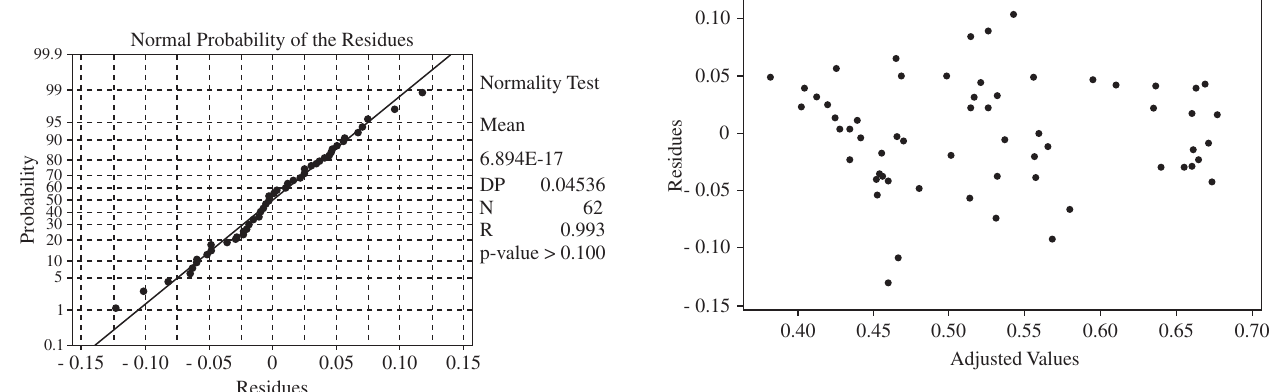
Figure 4. Graph of the residues as a function of adjusted values – reduced